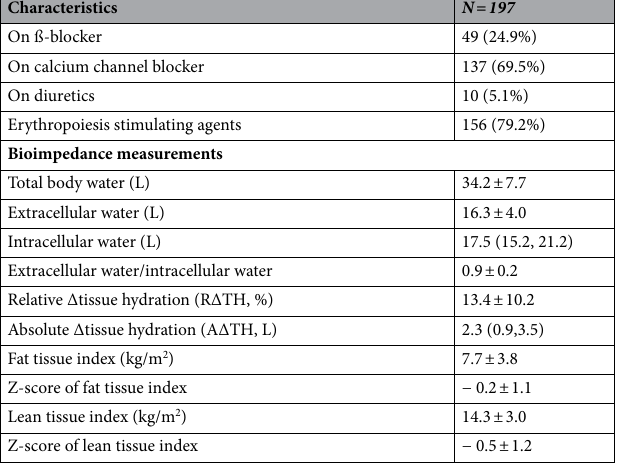
Table 1. Baseline demographic and biochemical details of the study subjects. Continuous variables are expressed as mean ± standard deviations (normal distribution) or as median and interquartile (non-normal distribution). Categorical variables are expressed as number, (%).